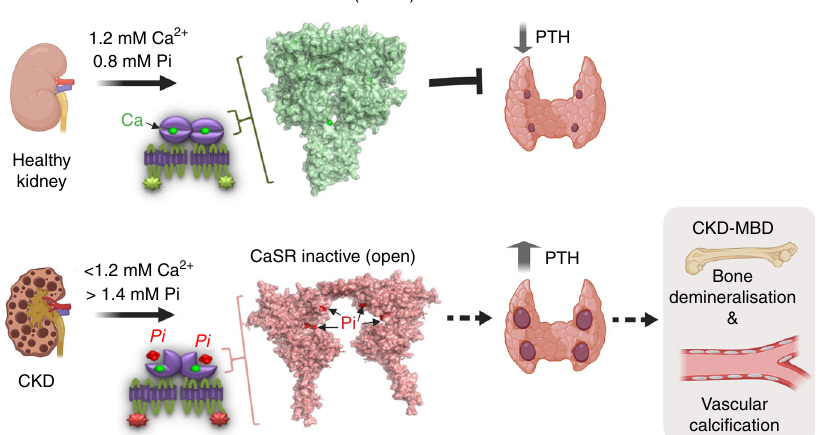
Fig. 8 Pi is an important regulator of CaSR activity. In health, CaSR negatively modulates PTH secretion to control Ca 2 + homeostasis. An acute rise in Pi inhibits the CaSR and would permit increased PTH secretion which stimulates renal Pi excretion to help restore normal serum Pi levels. However, in the hyperphosphatemia of CKD, the additional Pi would stabilize the CaSR ’ s inactive conformation permitting chronically elevated PTH secretion and contributing to SHPT progression. CaSR-ECD crystal models obtained from PDB 5k5s (active) and 5k5t (inactive) and shown as surface. Created with